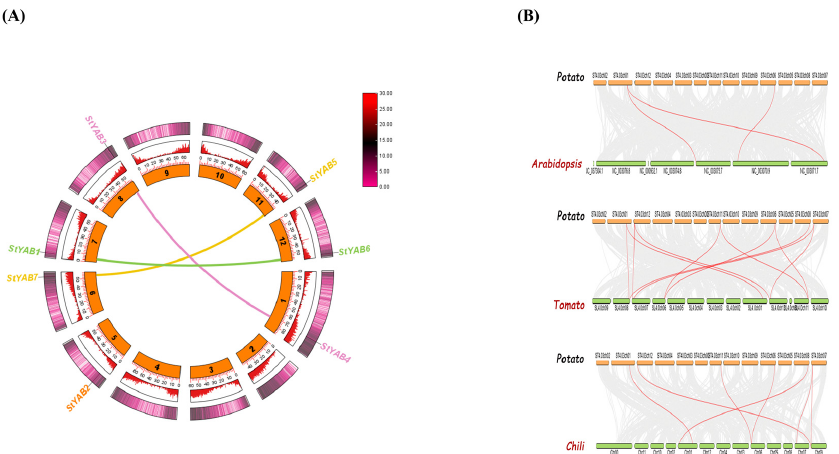
Figure 5. ( A ) The genome-wide synteny analysis of StYAB genes showing the dominance of segmental duplication and rare occurrence of tandem duplication. The joining lines show the duplicated StYAB genes in the genome. ( B ) Dual synteny analysis of potato-Arabidopsis, potato-tomato, and potato-chili. The orange bars represent the chromosomes of potato while the green bars represent the chromosomes of Arabidopsis, tomato, and chili, respectively. The red lines show the duplicated genes in the respective genomes.